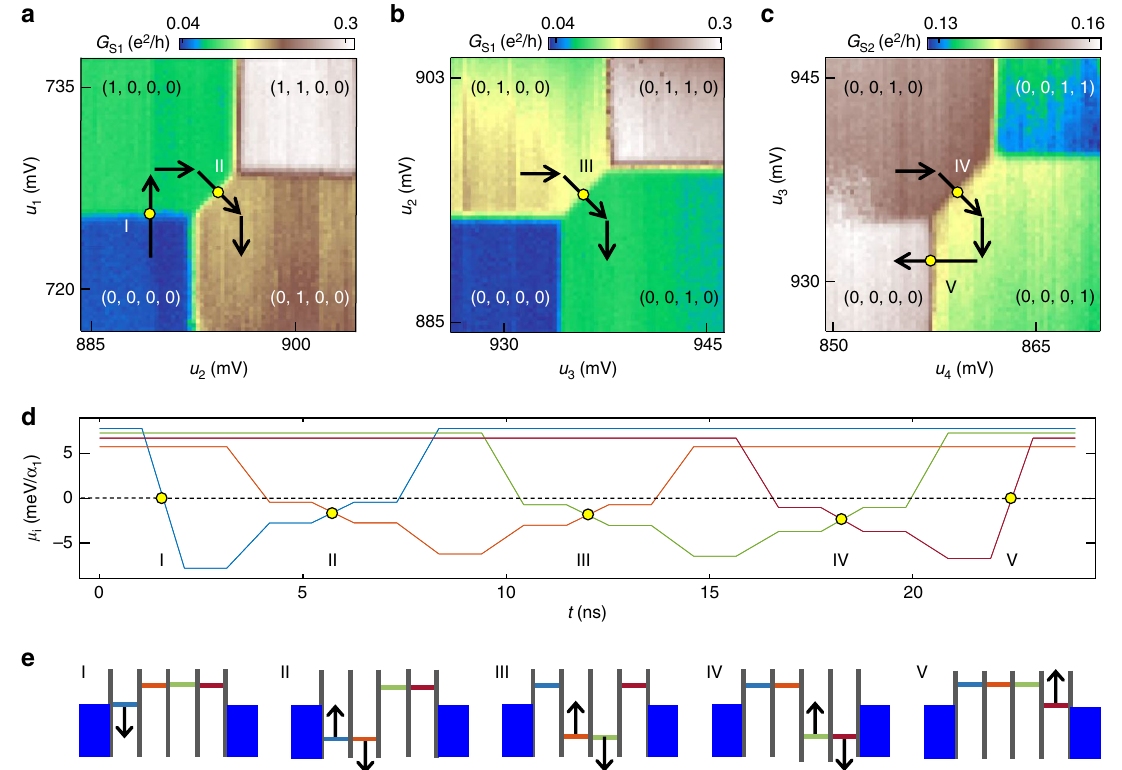
Fig. 3 4-dot charge shuttling trajectory a – c , Pairwise charge stability diagrams for dots 1 – 4, as measured in virtual gate voltage space. The leftmost charge sensor is used to acquire a and b , while the center charge sensor is used to acquire c . The shuttling trajectory through 4-dot charge stability space is overlaid on the data. Different portions of the pulse sequence are labeled with roman numerals for reference in d and e . d The chemical potential of dots (1, 2, 3, and 4) is plotted in (blue, orange, green, and maroon) for the shuttling sequence. The frequency of the shuttling sequence is varied by changing the length of the voltage plateaus, which alters the dwell time in each charge state. 1 ns ramp times between voltage plateaus are used in conjunction with low pass fi lters such that the interdot charge transfers are adiabatic with respect to interdot tunnel coupling. e Energy level diagrams at the positions in the pulse sequence marked with yellow dots in a – d and linked to the corresponding roman numerals. The arrows indicate the direction the energy levels are being swept and the colors of the levels correspond to the colors of the pulses in d